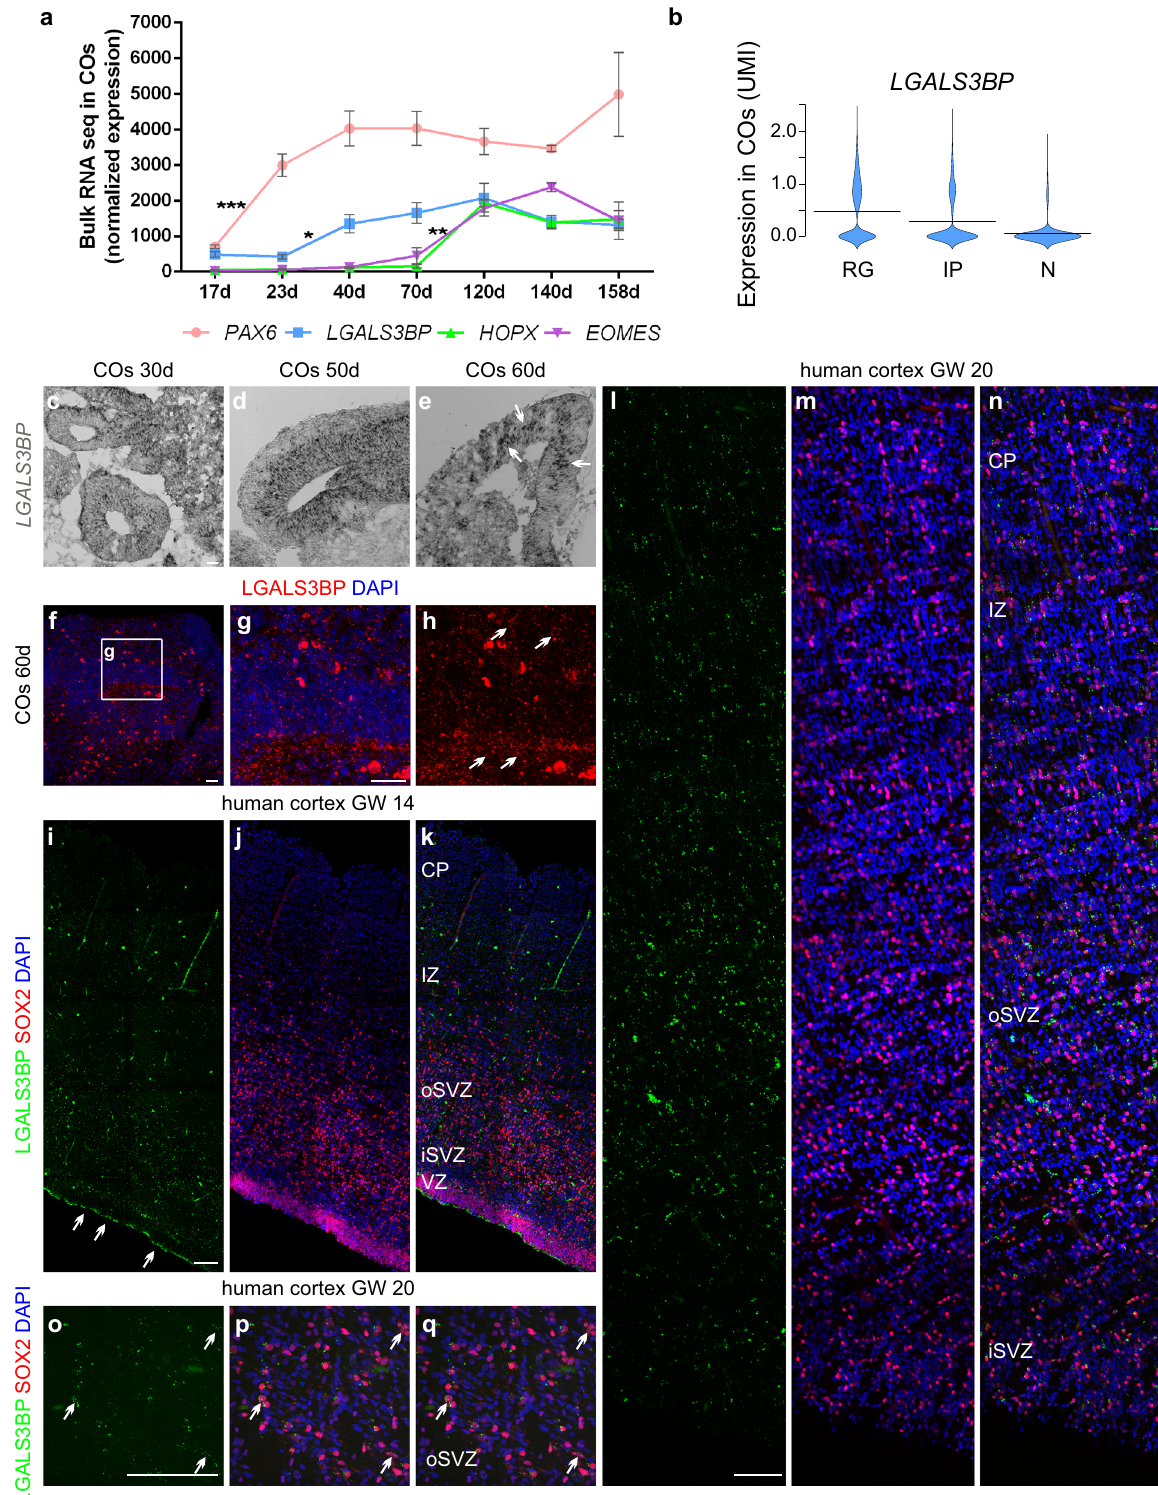
defective neurogenesis in humans. The enrichment of loci with rare de novo variants in individuals with the neurodevelopmental condition called periventricular nodular heterotopia (PH) was recently described, suggesting the involvement of these genes in the pathogenesis of this disease 11,43 . In this study 11 , one individual with a de novo missense variant in LGALS3BP (indi- vidual 1, c.1108 G > A [p.Glu370Lys]; RefSeq NM_005567.4)